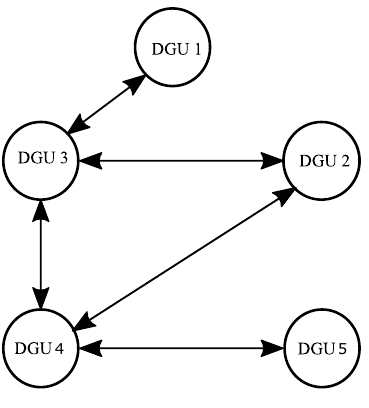
Figure 1. Communication network of 5 generation units (DGUs) in a DC